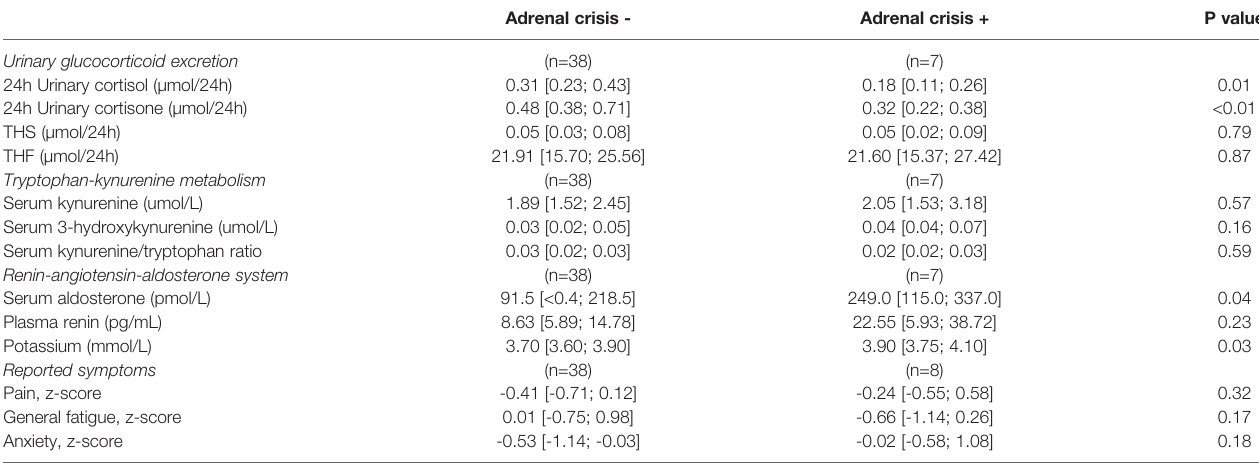
TABLE 7 | Urinary glucocorticoid excretion, tryptophan-kynurenine metabolism, renin-angiotensin-aldosterone system and self-reported aspects of quality in life in patients on the higher dose hydrocortisone (0.4-0.6